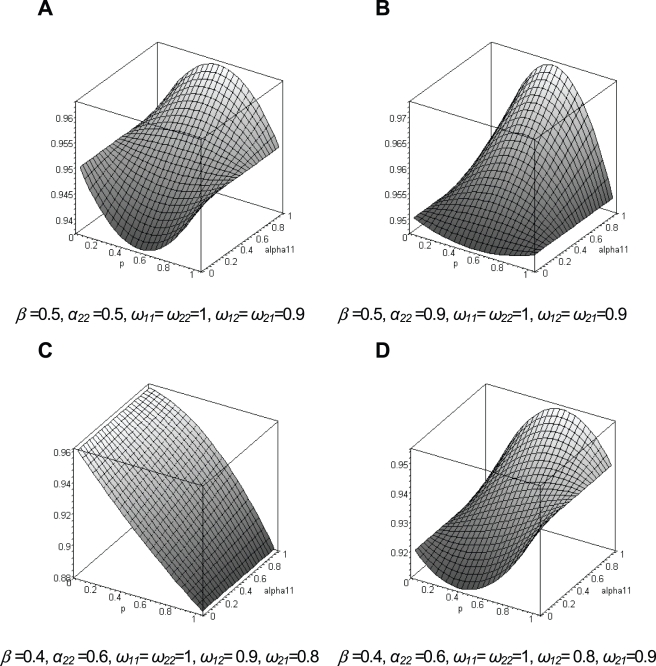
Population fitness landscape (z-axis) as a function of the frequency (p) of the alternative splicing variant P
1, and its specificity for tissue T
1 (α
11).See text for the definition of the other parameters.